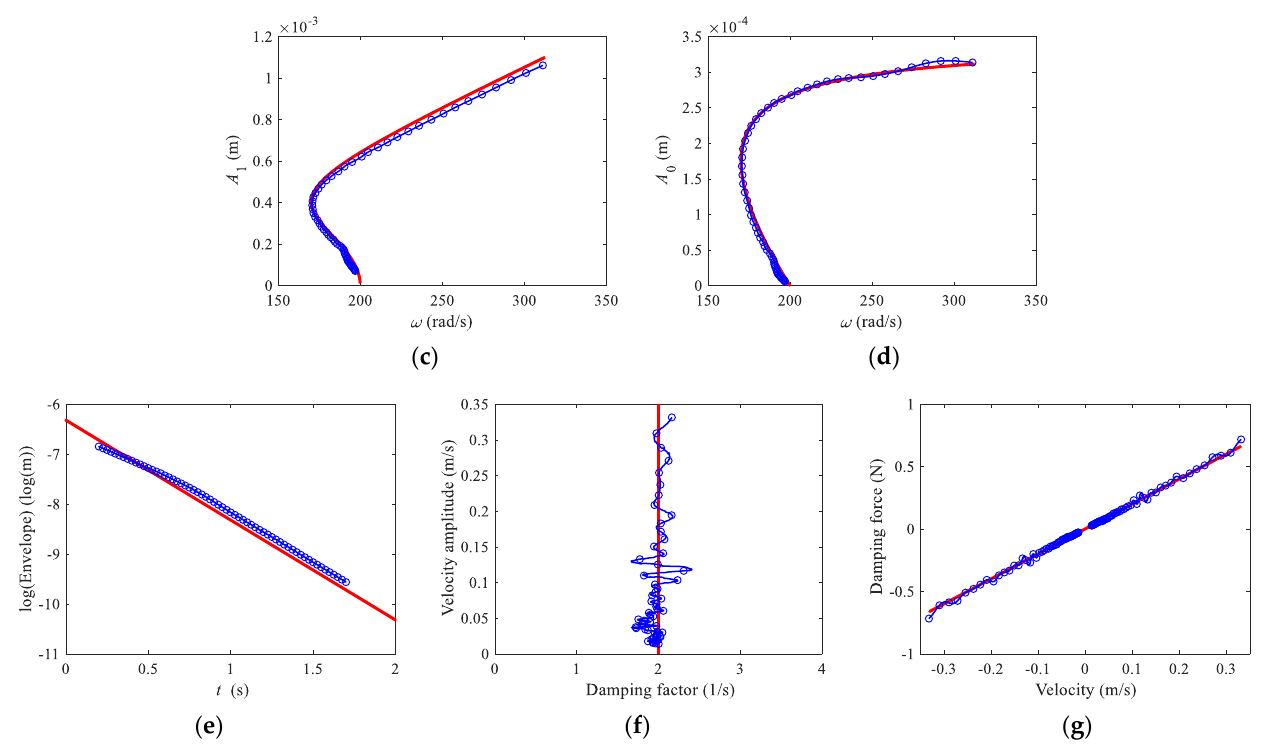
Figure 5. Wavelet transform. ( a ) Time-domain response and envelope, ( b ) spectrogram, ( c ) backbone curve of first harmonic term A 1 , ( d ) backbone curve of bias term A 0 , ( e ) logarithmic form of the envelope, ( f ) damping factor, ( g ) damping force curve. Thin solid line, time domain response; dashed line, envelope; dotted line, instantaneous frequency; thick solid lines, analytical solutions; lines with circles, numerical results.